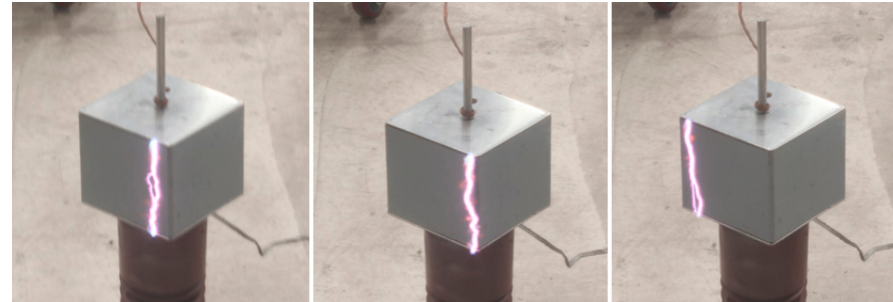
Figure 10. Flashover path on the